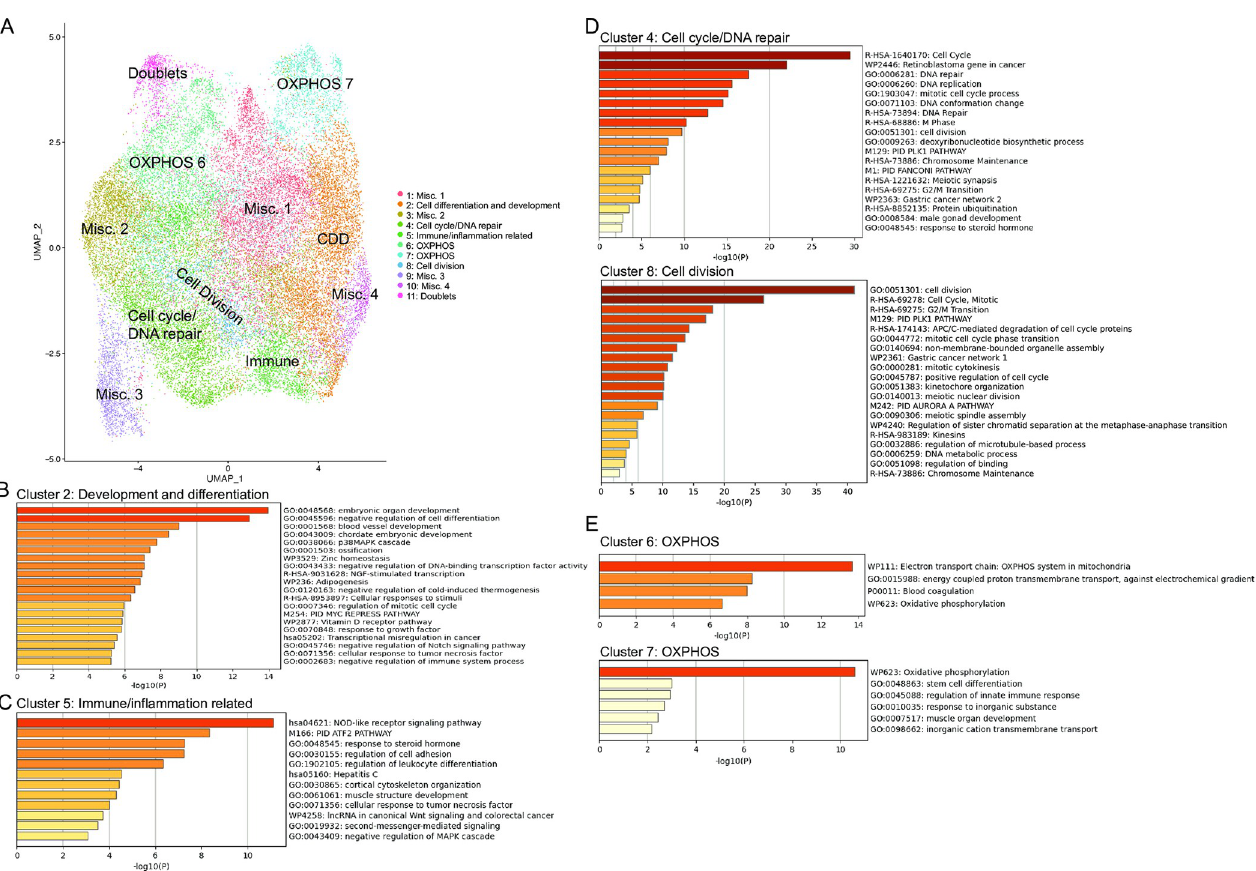
Fig 1. Single cell analysis identifies cell subpopulations in a HGSOC cell line. (A) Uniform Manifold Approximation and Projection for Dimension reduction (UMAP) dot plot of cells from all samples colored by cluster. (B-E) Enriched pathways identified by Metascape analysis of positively associated marker genes in clusters 2 (B), 5 (C), 4 and 8 (D), and 6 and 7